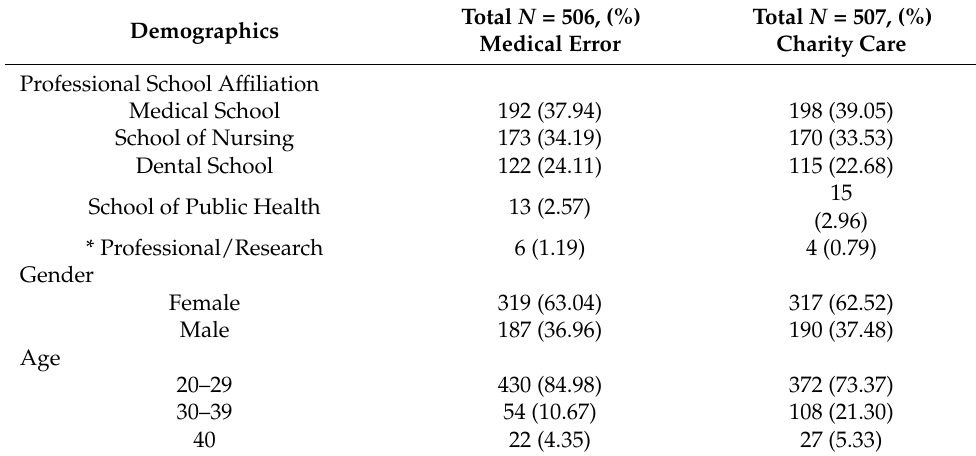
Table 2. Demographics of students participating two virtual simulations from August 2020–May 2021. ( N = 1013) students.